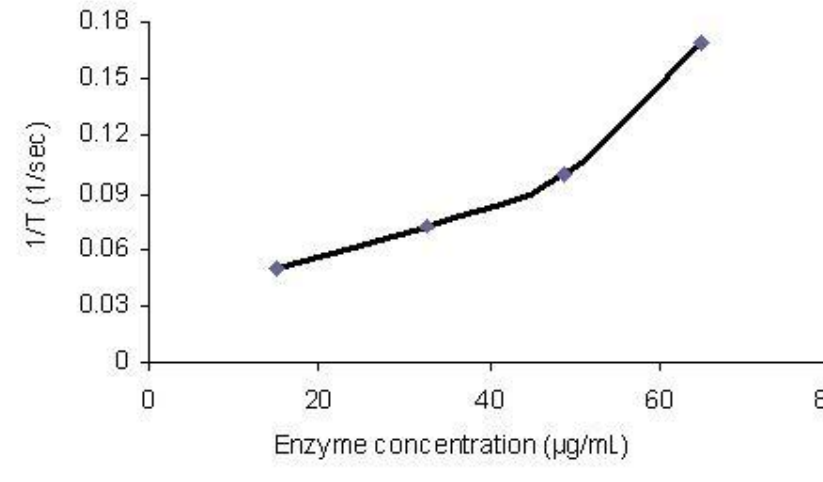
Figure 6. Clotting activity of AH143 on human plasma. Inhibition of Enzyme